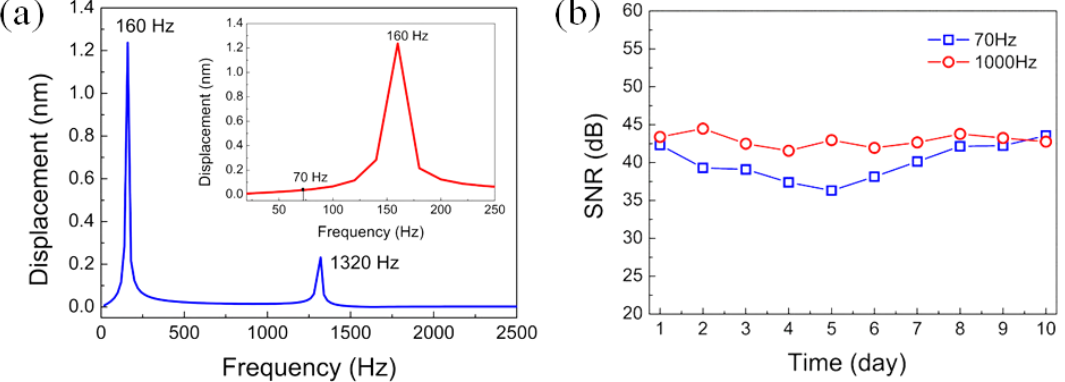
Figure 11. ( a ) Frequency response to waterborne sound of the wheel-shaped glass diaphragm-based fiber-optic microphone simulated at 1 Pa pressure, ( b ) SNRs of the fiber-optic microphone at 70 and 1000 Hz measured underwater on different days.